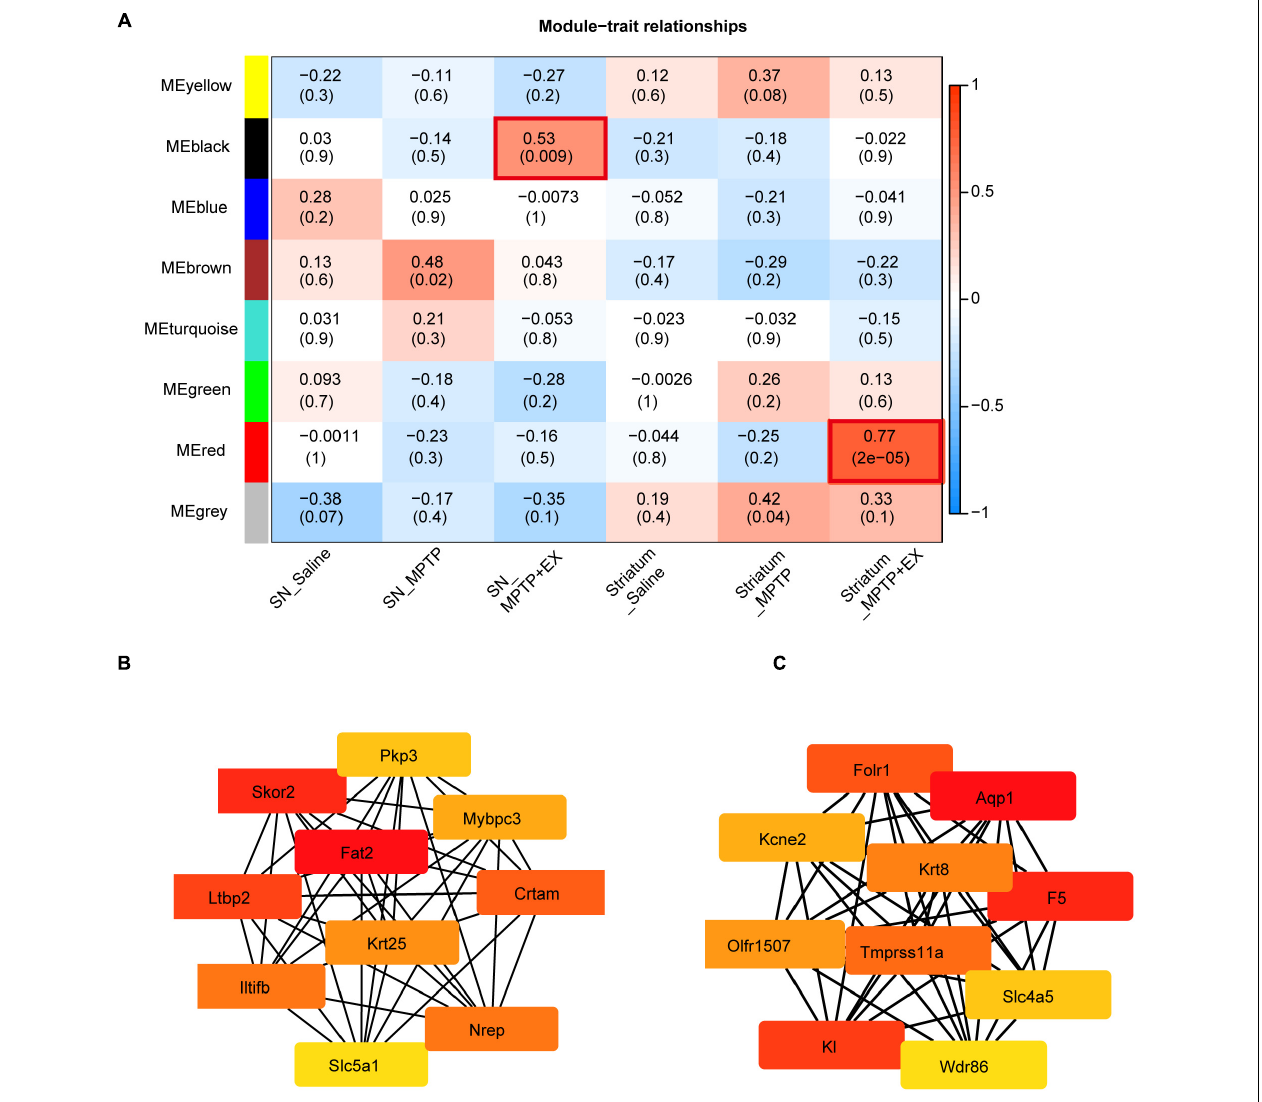
FIGURE 4 | Identification of modules associated with the exercise treatment for PD mice in SN and striatum. (A) Heatmap of the correlation between the module eigen genes and exercise treatment of PD. We selected the MEblack-grade block and MEred-grade block for subsequent analysis according to the p -value and Pearson’s coefficient. (B,C) Hub genes analysis in the MEblack-grade block and MEred-grade block (ME: Module Eigen